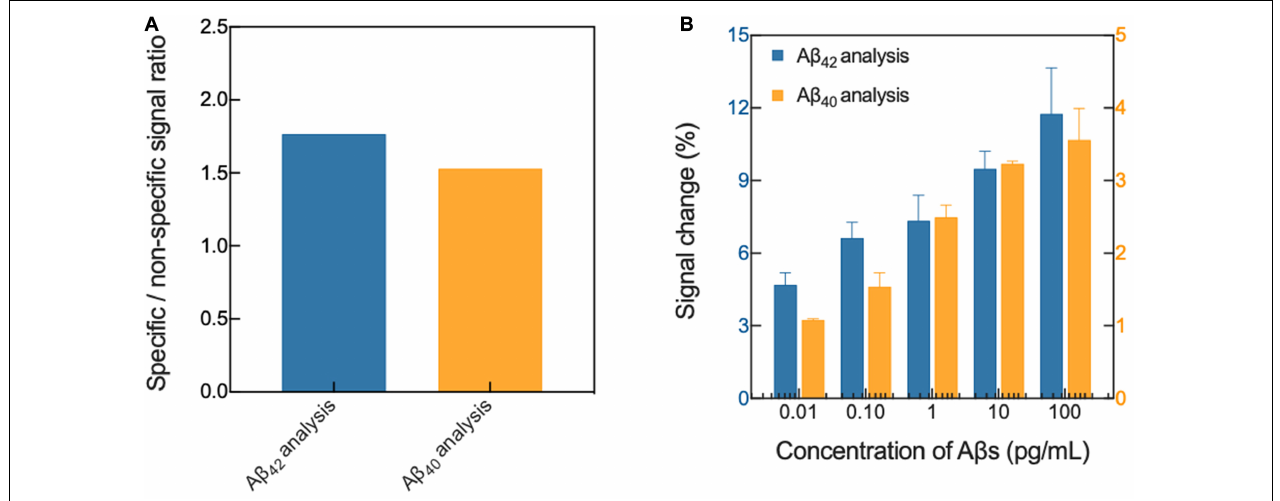
FIGURE 1 | Verification of (A) selectivity and (B) sensitivity of the biosensor in 1 mM PBS. A β , amyloid- β ; PBS, phosphate-buffered saline.